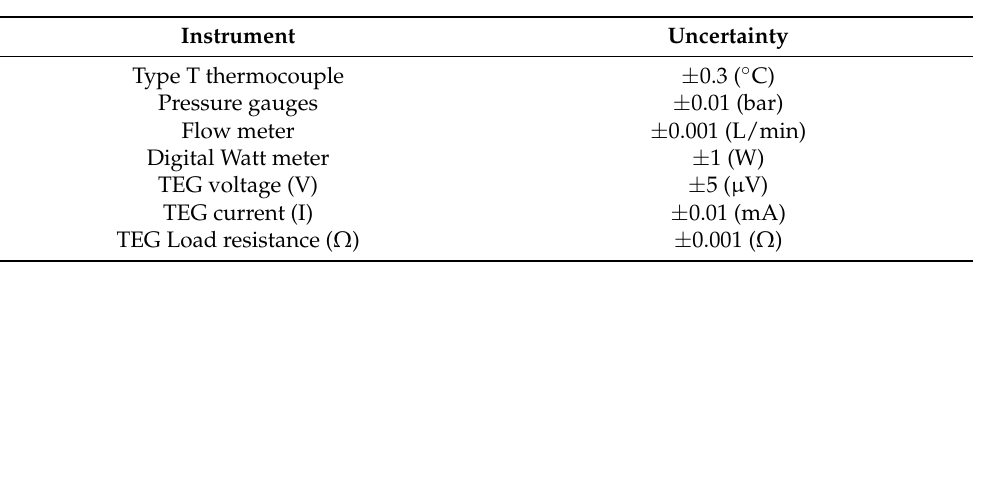
Table 1. Uncertainty of measuring